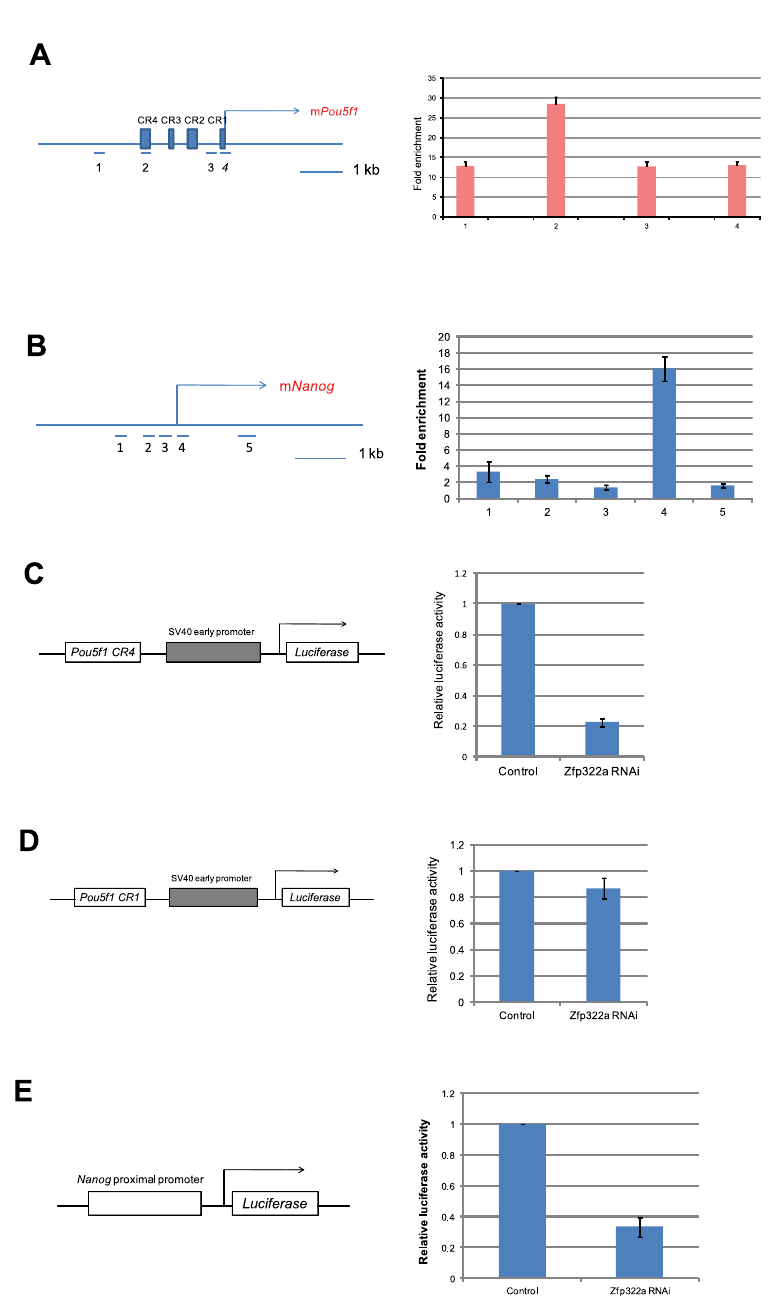
Figure 3. Zfp322a positively regulates Oct4 and Nanog transcription. ( A ) Zfp322a binds to Oct4 distal enhancer regions. Zfp322a ChIP DNA was analyzed by real-time PCR. Locations of primers used in qPCR were mapped to the Pou5f1 genomic region. ( B ) Zfp322a binds to Nanog proximal promoter, with a highest enrichment fold at TSS starting site. Locations of primers were pictured on mouse Nanog genomic region. Relative luciferase activities were down-regulated upon Zfp322a RNAi using Pou5f1 CR4-pSV40- Luc construct ( C ) and p Nanog PP- Luc construct ( E ), but not Pou5f1 CR1- pSV40- Luc construct ( D ). Schematic structures of the constructs were presented. Empty pSUPER.puro vector were transfected in ES cells as a control RNAi. Renilla luciferase vector were transfected simultaneously and relative luciferase activities were normalized against Renilla luciferase